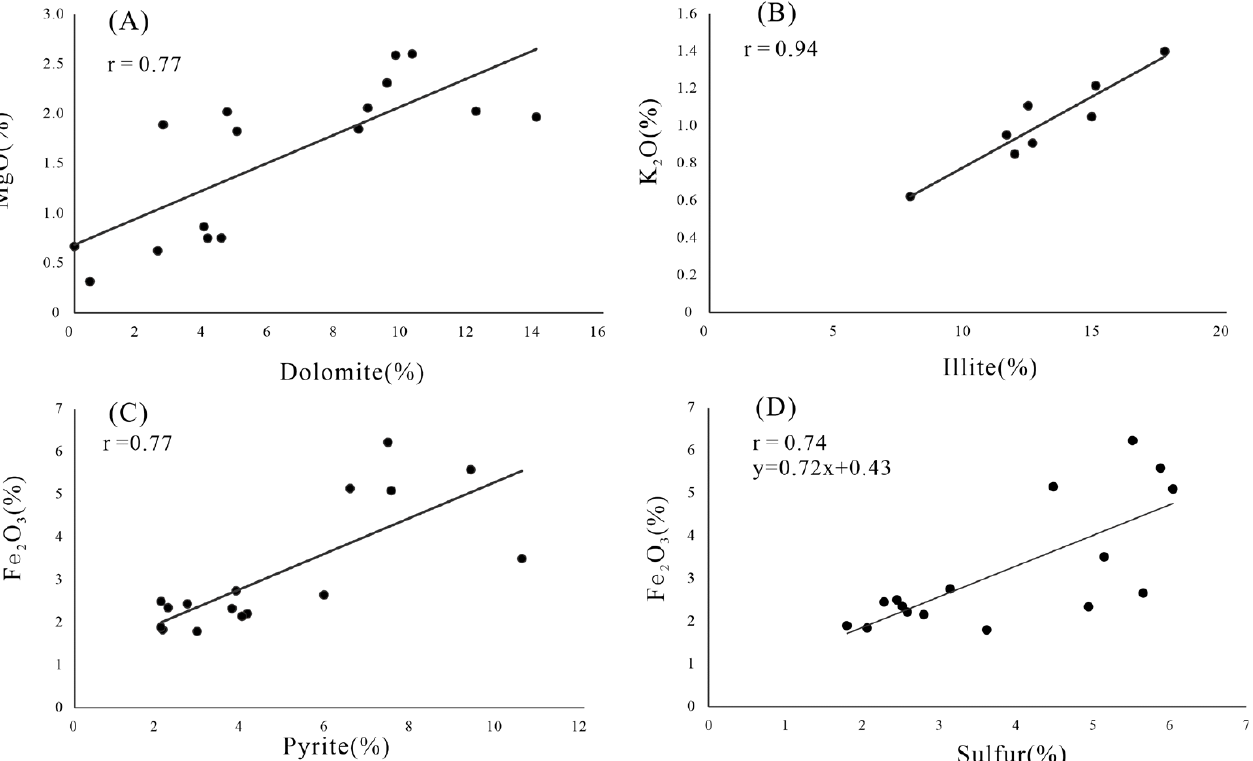
Figure 7. Relationship among selected elements and minerals: ( A ) plot of MgO vs. dolomite; ( B ) plot of K 2 O vs. illite; ( C ) plot of Fe 2 O 3 vs. pyrite; and ( D ) plot of Fe 2 O 3 vs. sulfur.